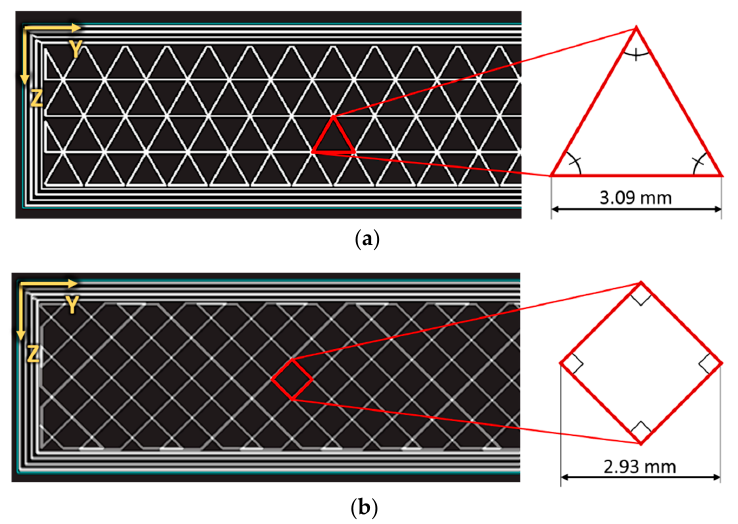
Figure 2. Extracted geometries of the unit-cells for the ( a ) T45 infill and the ( b ) R20 infill. Note that the for the R20 infill, the printer prints the infill with unidirectional layers (+45° or − 45°); therefore, the figure ( b ) was obtained as the superposition of two subsequent layers.